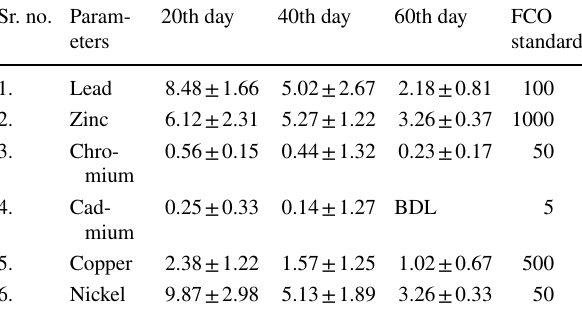
Table 6 Heavy metal analysis of compost in Mandi